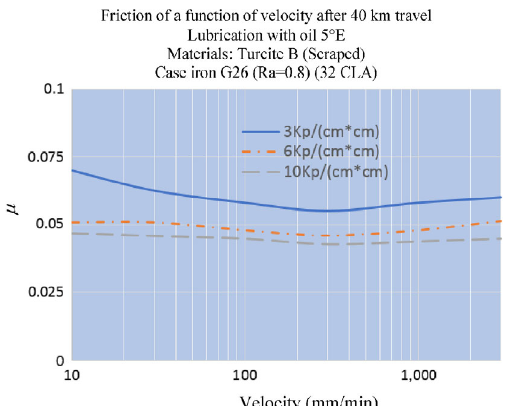
Fig. 18 COF under lubrication friction condition for PTFE